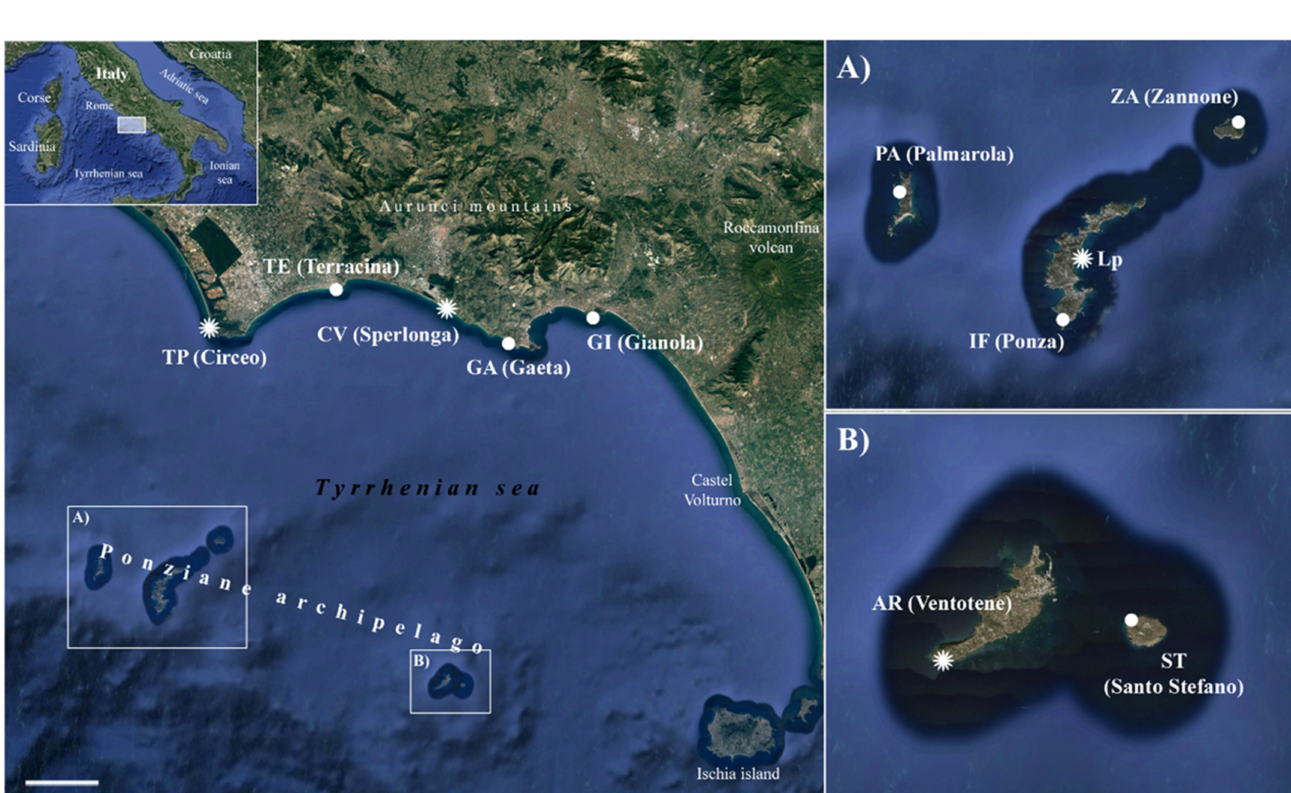
Figure 1. Map of the Limonium populations studied; detailed maps of islands ( A ) Palmarola, Ponza, and Zannone, and ( B ) Ventotene and Santo Stefano. Codes follow Table